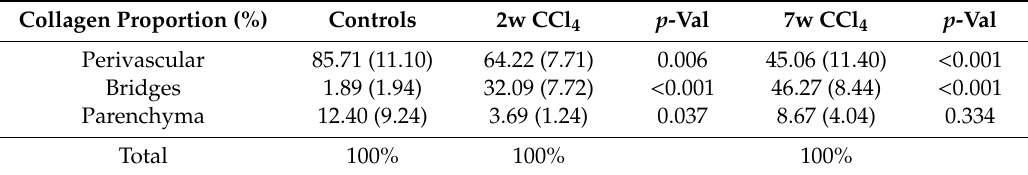
Table 2. Liver collagen proportion per ROI. Mean percentages ( ±